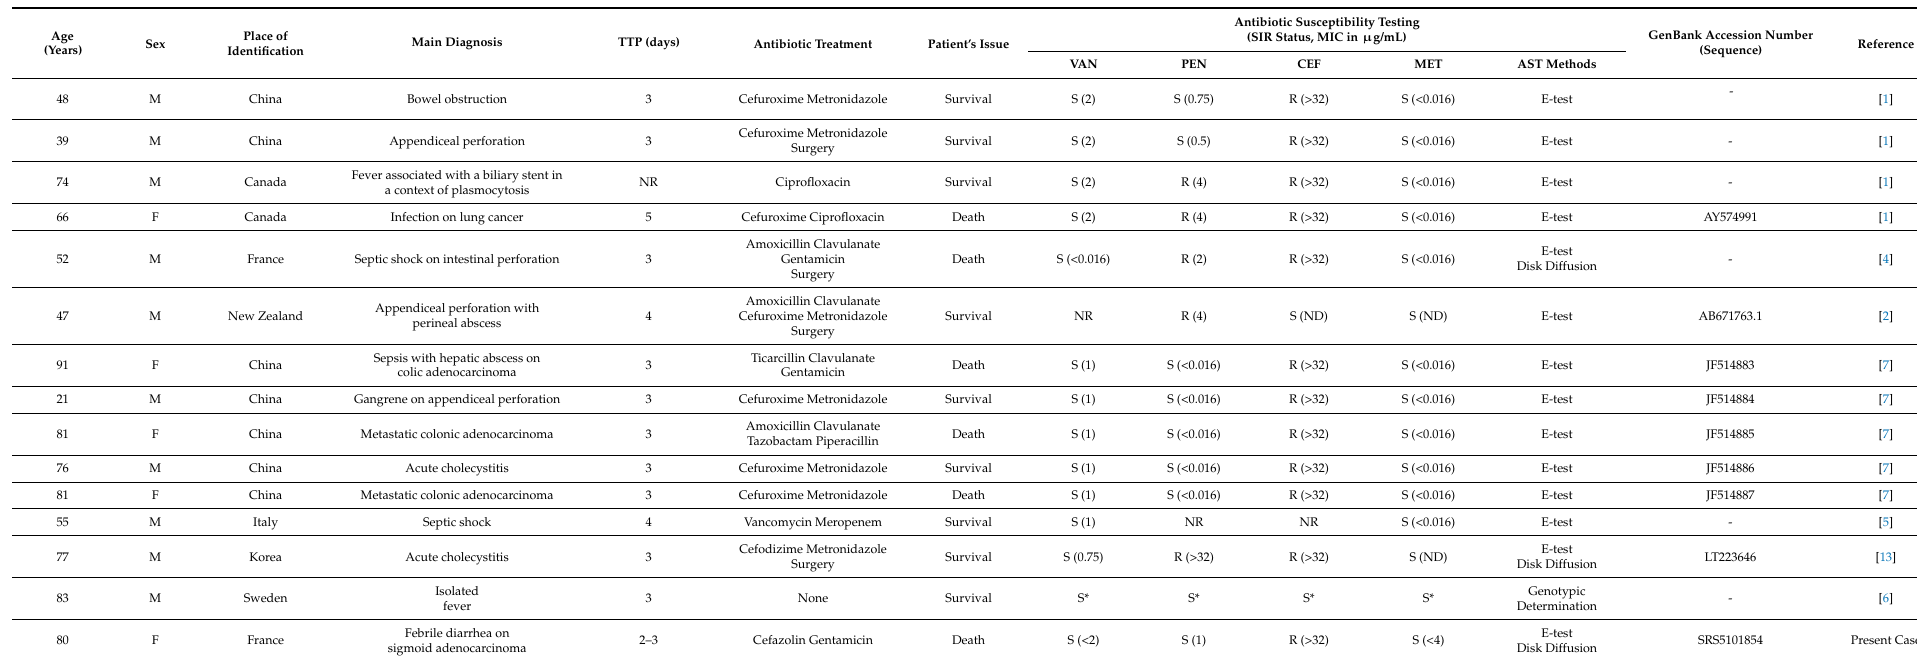
Table 1. Clinical presentations of Catabacter hongkongensis bacteremia. TTP: time to positive results; CEF: cefotaxime; MET: metronidazole; MIC: minimum inhibitory concentration; ND: non-determined; -: sequences were not reported; PEN: penicillin; R: resistant; S: susceptible; VAN: vancomycin, S*: absence of the gene associated with antibiotic resistance. All the described cases were associated with gastrointestinal diseases. These fifteen cases highlight the severity of infection by Catabacter hongkongensis . This severity is independent of the undertaken clinical management. The antibiotic susceptibility testing of the isolated strains demonstrates: i/the inconsistent effectiveness of beta-lactamines (including cephalosporins) and ii/the constant efficacy of vancomycin and